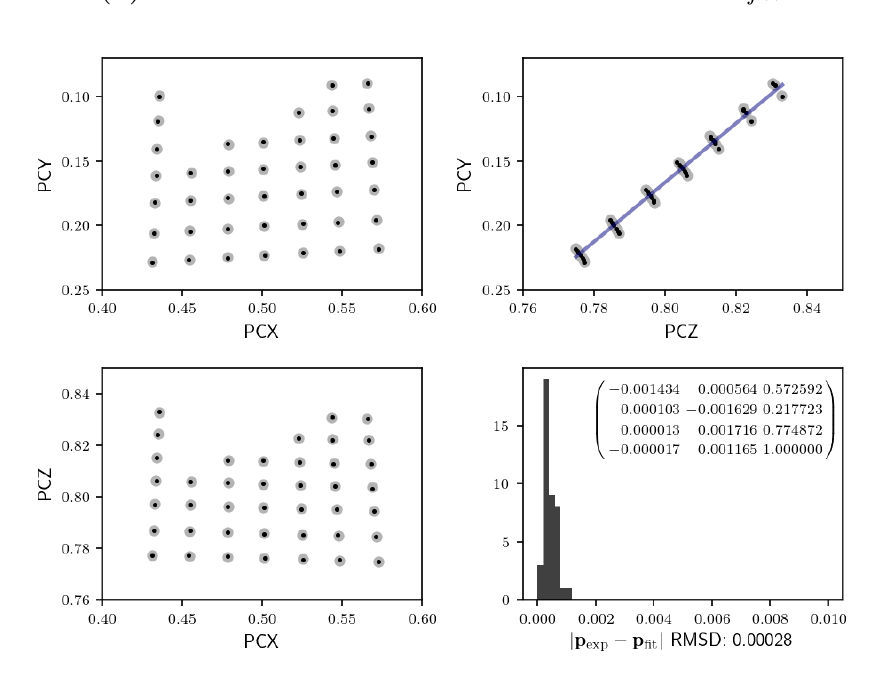
Figure 3. Fit of transformation matrices to the individual experimental projection center (PC) coordinates. The small black points are the experimental data points, and the larger gray filled circles are the respective fit results according to ( a ) the affine transformation matrix A fit and ( b ) the projective transformation matrix P fit shown in the lower right panels. Experimental data points were measured on a 7 × 7 subgrid and selected according to a minimum allowed cross-correlation coefficient r min = 0.65. This resulted in the 41 calibration points as shown in the